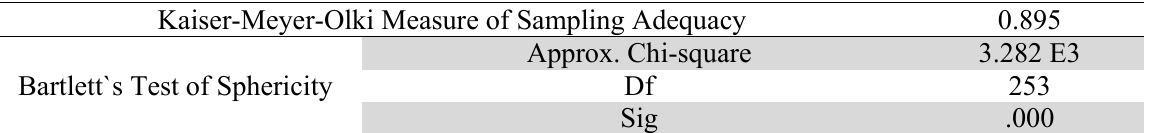
The results of KMO test